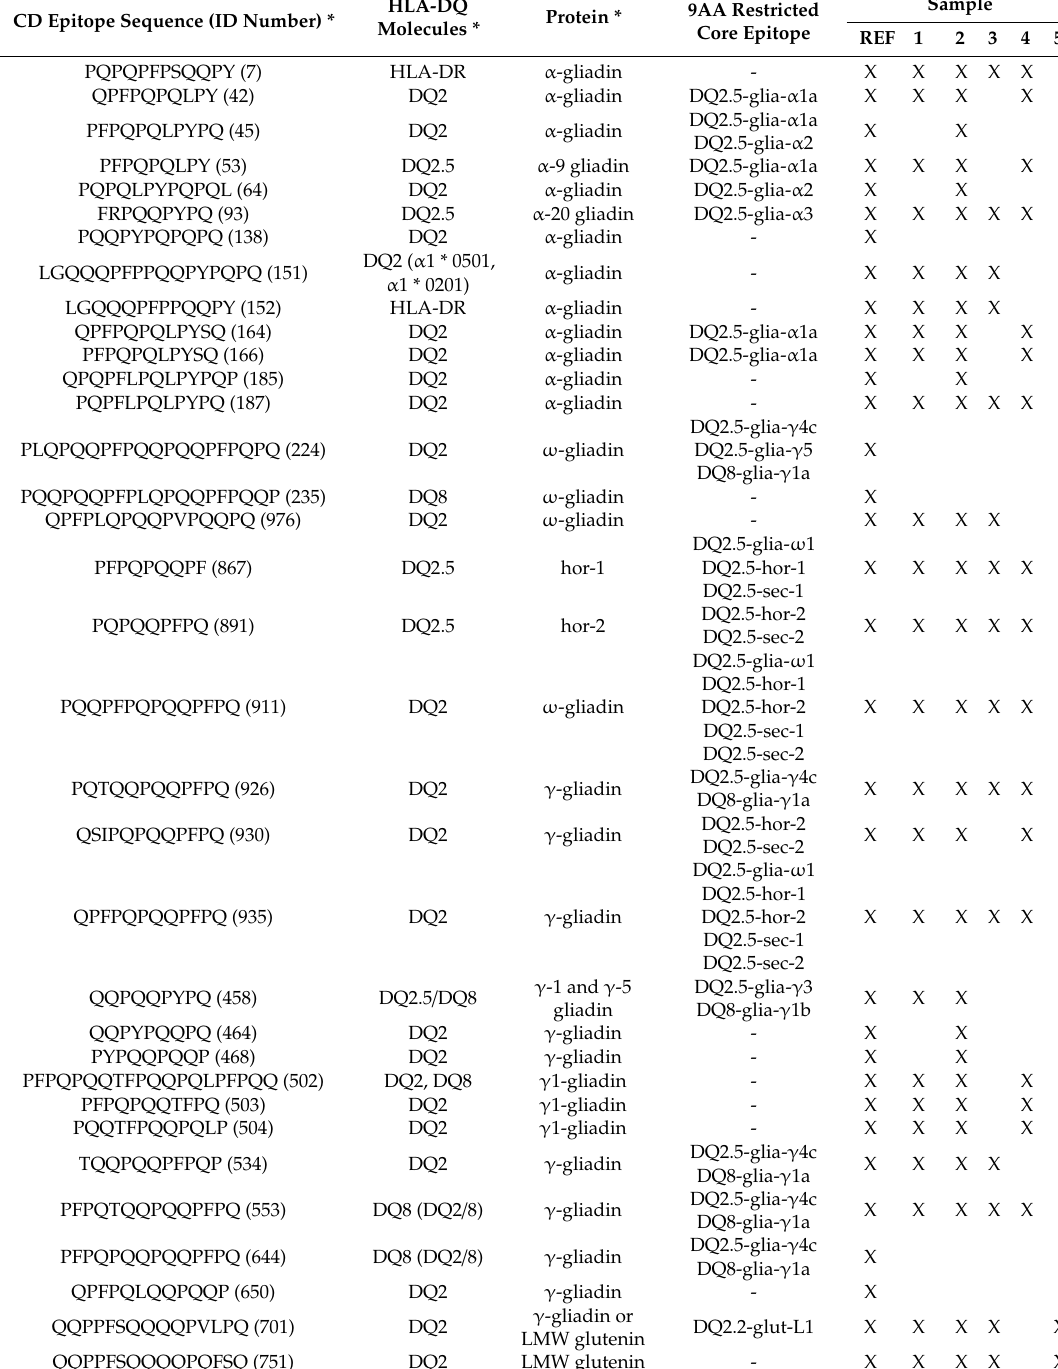
Table 4. Restricted list of gastroduodenal resistant CD epitopes highlighted for their di ff erential expressionamongtheanalyzedsetofsamples(*sourcehttp: // www.allergenonline.org / celiachome.shtml, accessed in June